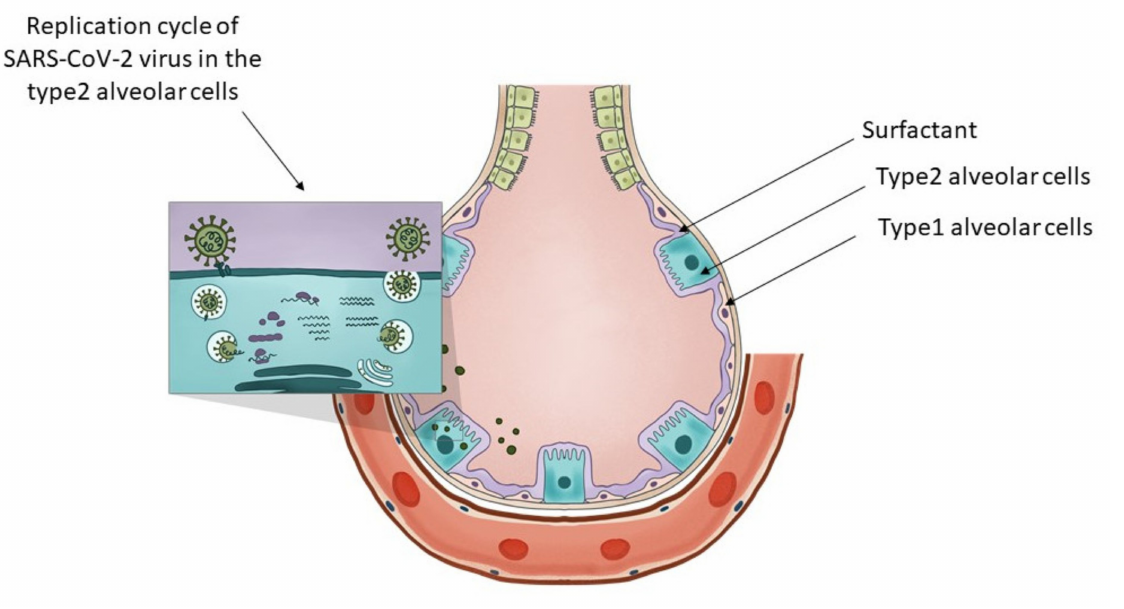
Figure 1. The key role of type 2 alveolar cells in the surfactant production and SARS-CoV-2 infection at the level of the lung alveolae. The insert on the top-left presents the major steps of the replication cycle of SARS-CoV-2 virus in the type 2 alveolar